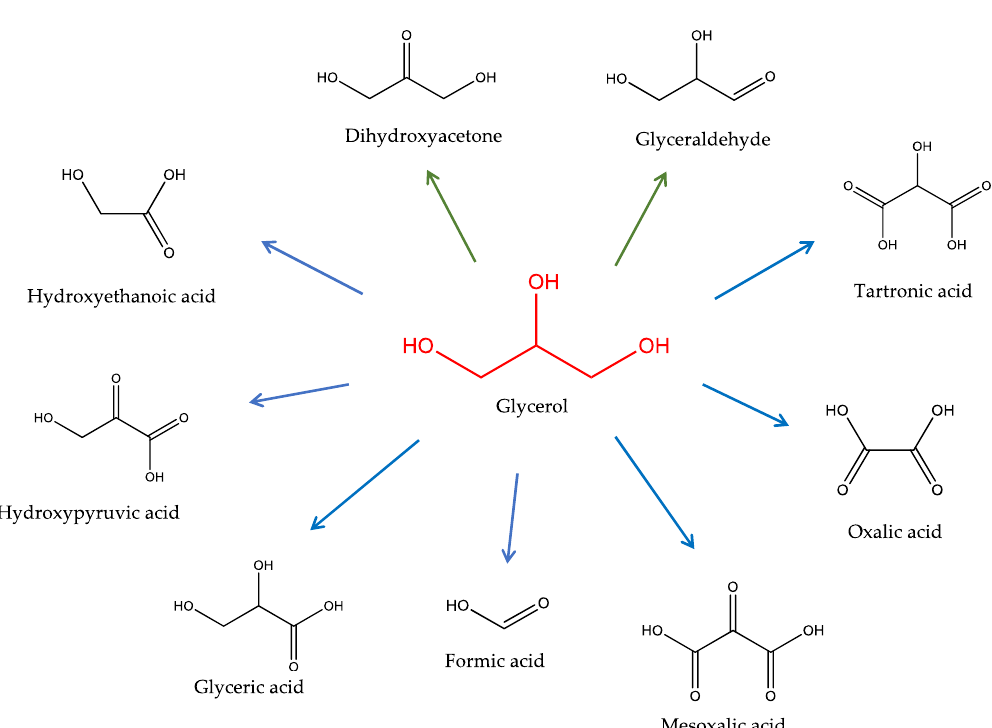
Figure 9. Products from glycerol oxidation. Adapted with permission. from Bartoli et al. [3], published by IntechOpen., 2019. Table 1. Obtained results for the oxidation of glycerol, using two di ff erent oxidants, in Zhang et al.’s work a,b